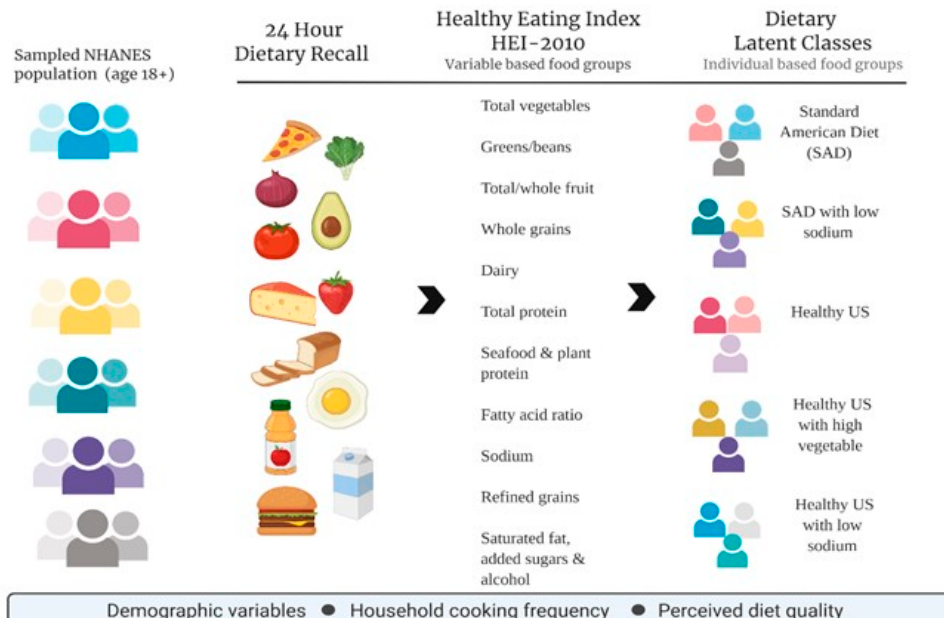
Figure 1. Overview of latent class profile analysis (LCPA) using daily Healthy Eating Index-2010 (HEI-2010) from dietary recall data collected from sampled National Health and Nutrition Examination Survey (NHANES) adults (age 18+).